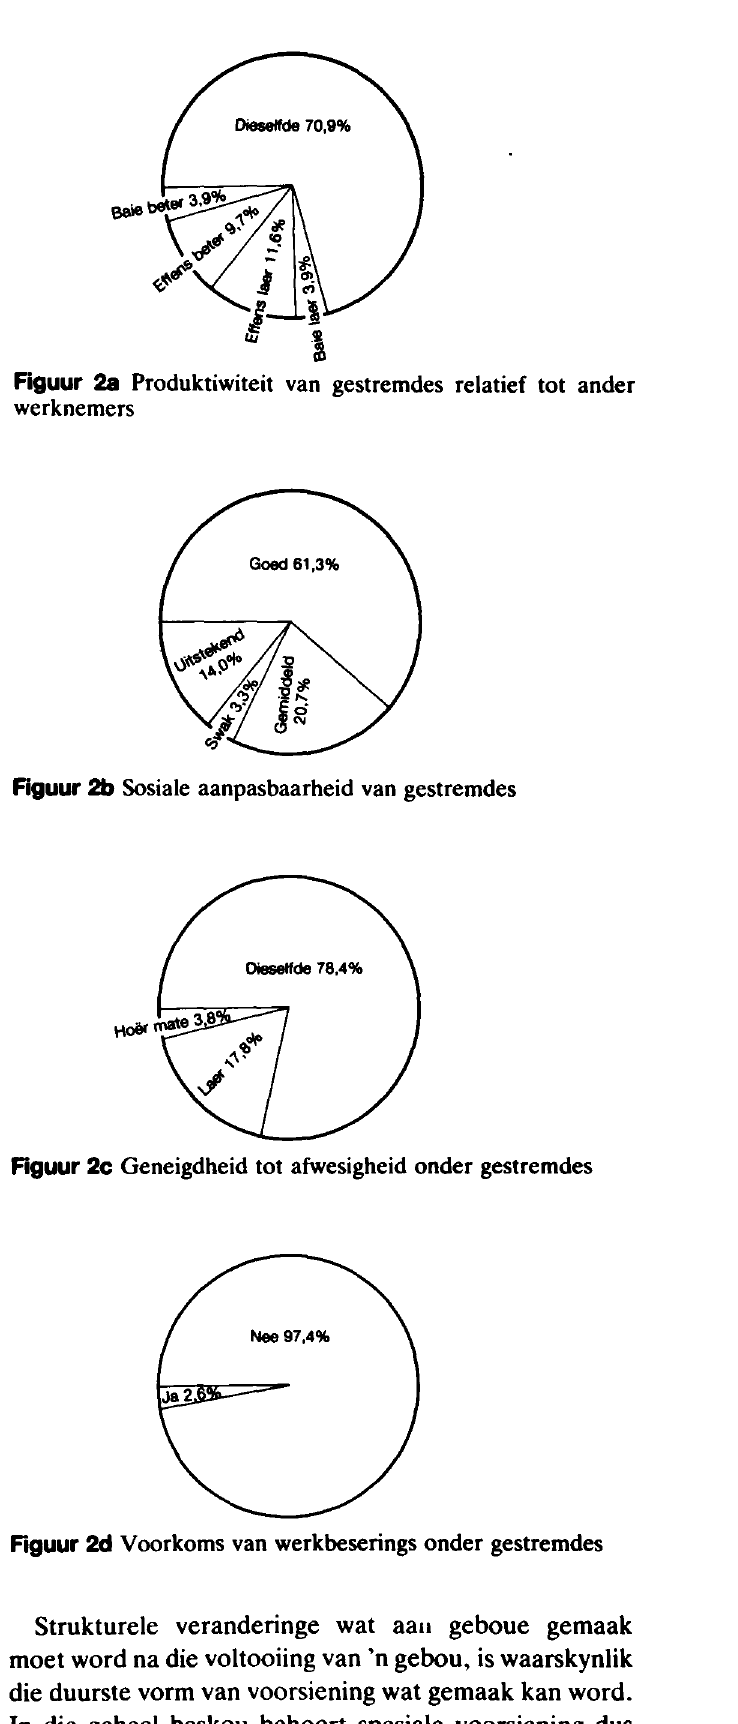
Figuur 2d Voorkoms van werkbeserings onder gestremdes Strukturele veranderinge wat aau geboue gemaak moet word na die voltooiing van 'n gebou, is waarskynlik die duurste vorm van voorsiening wat gemaak kan